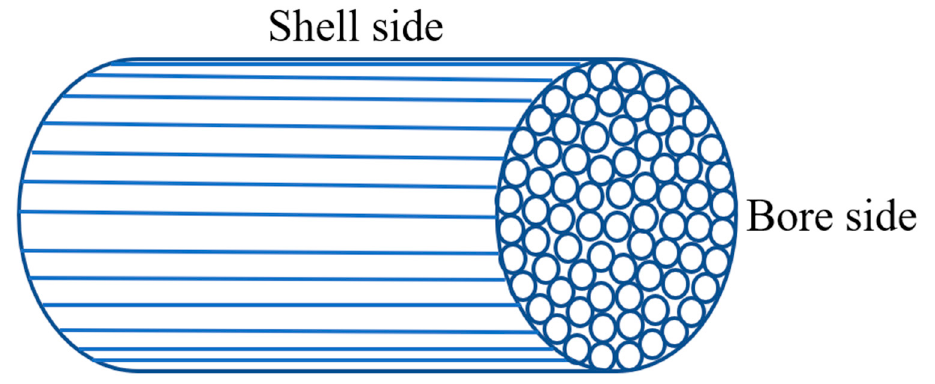
Figure 2. Hollow fiber membranes.